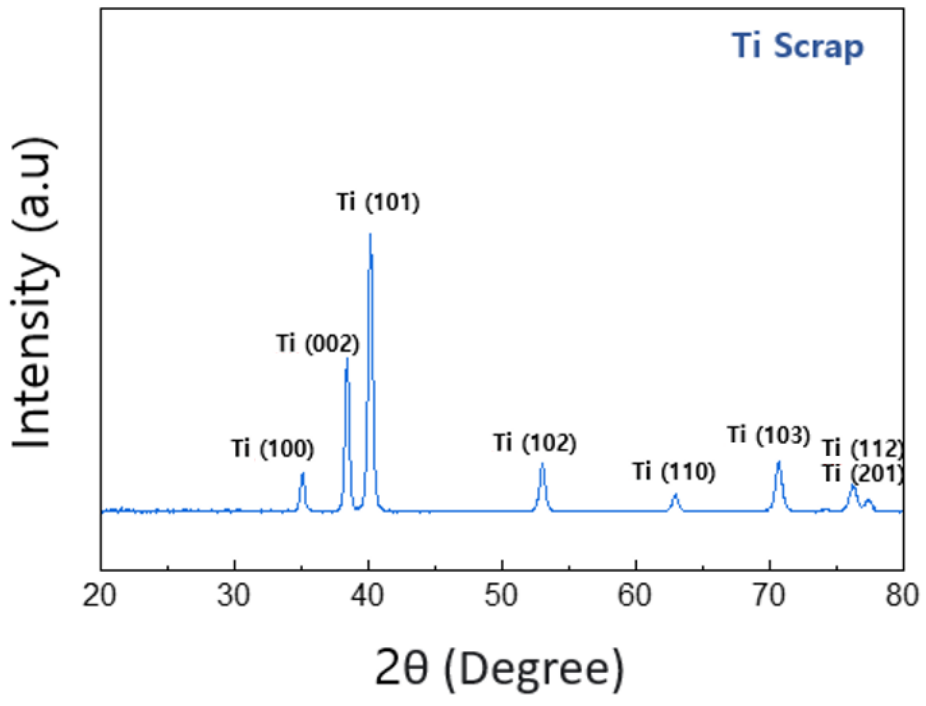
Figure 7. Result of XRD of the deoxidated Ti scrap.